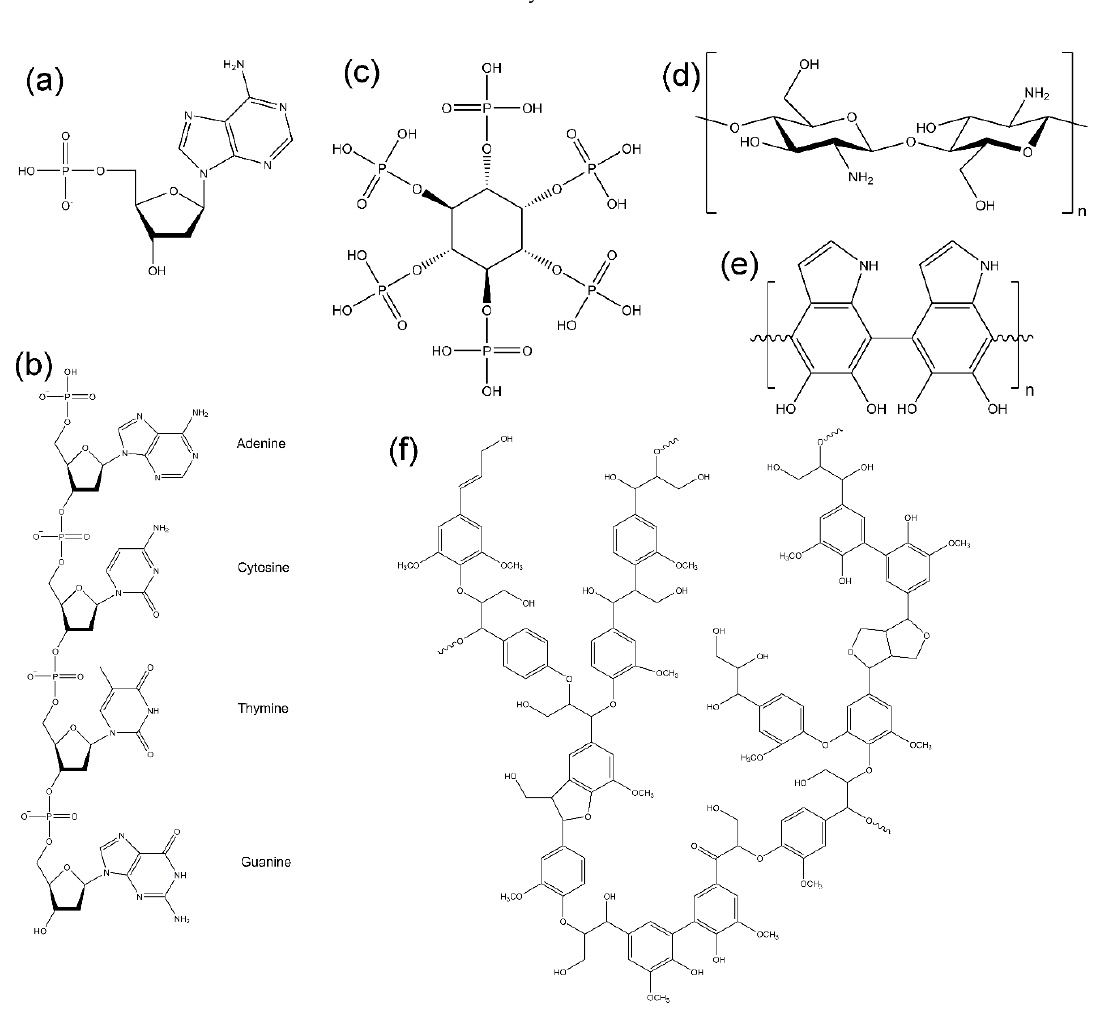
Figure 13. Natural flame-retardant additives: ( a ) deoxyribonucleic acid (DNA), ( b ) chain of DNA, ( c ) phytic acid, ( d ) chitosan, ( e ) polydopamine, and ( f ) lignin. ( c ) phytic acid, ( d ) chitosan, ( e ) polydopamine, and ( f )